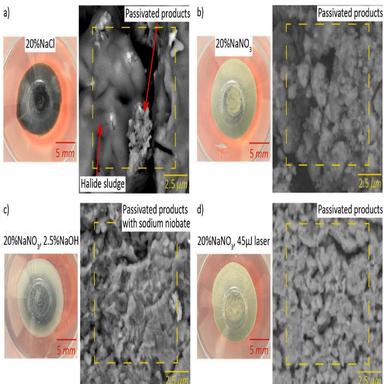
Analysis of the NbC–Ni cermet reaction products. The centrifuged reaction products inside falcon tubes and SEM micrographs of powder samples at 15000x with a) ECM in 20% NaCl, b) ECM in 20% NaNO3, c) ECM in 20% NaNO3 with 2.5% NaOH and d) LECM in 20% NaNO3.